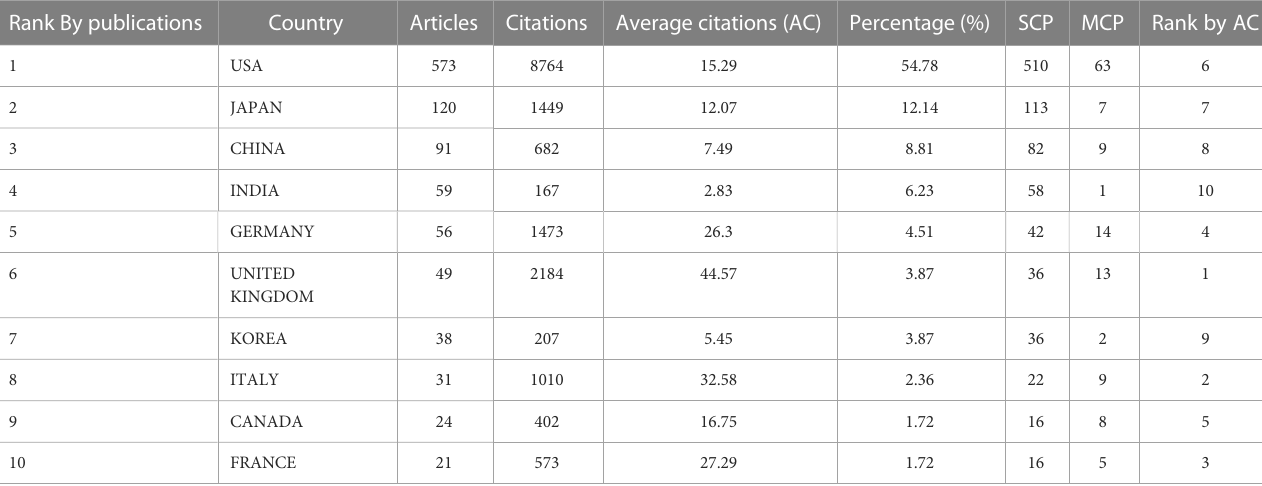
TABLE 4 The top 10 countries based on publications and citations.